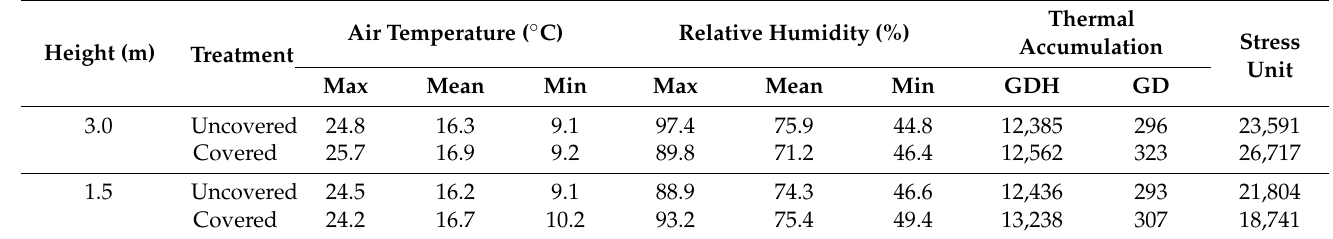
Table 1. Air temperature, relative humidity, thermal accumulation and stress index between 1 November 2017 and 15 December 2017 in sweet cherry trees with and without rain cover at 3 and 1.5 m heights. Central Valley, Chile.